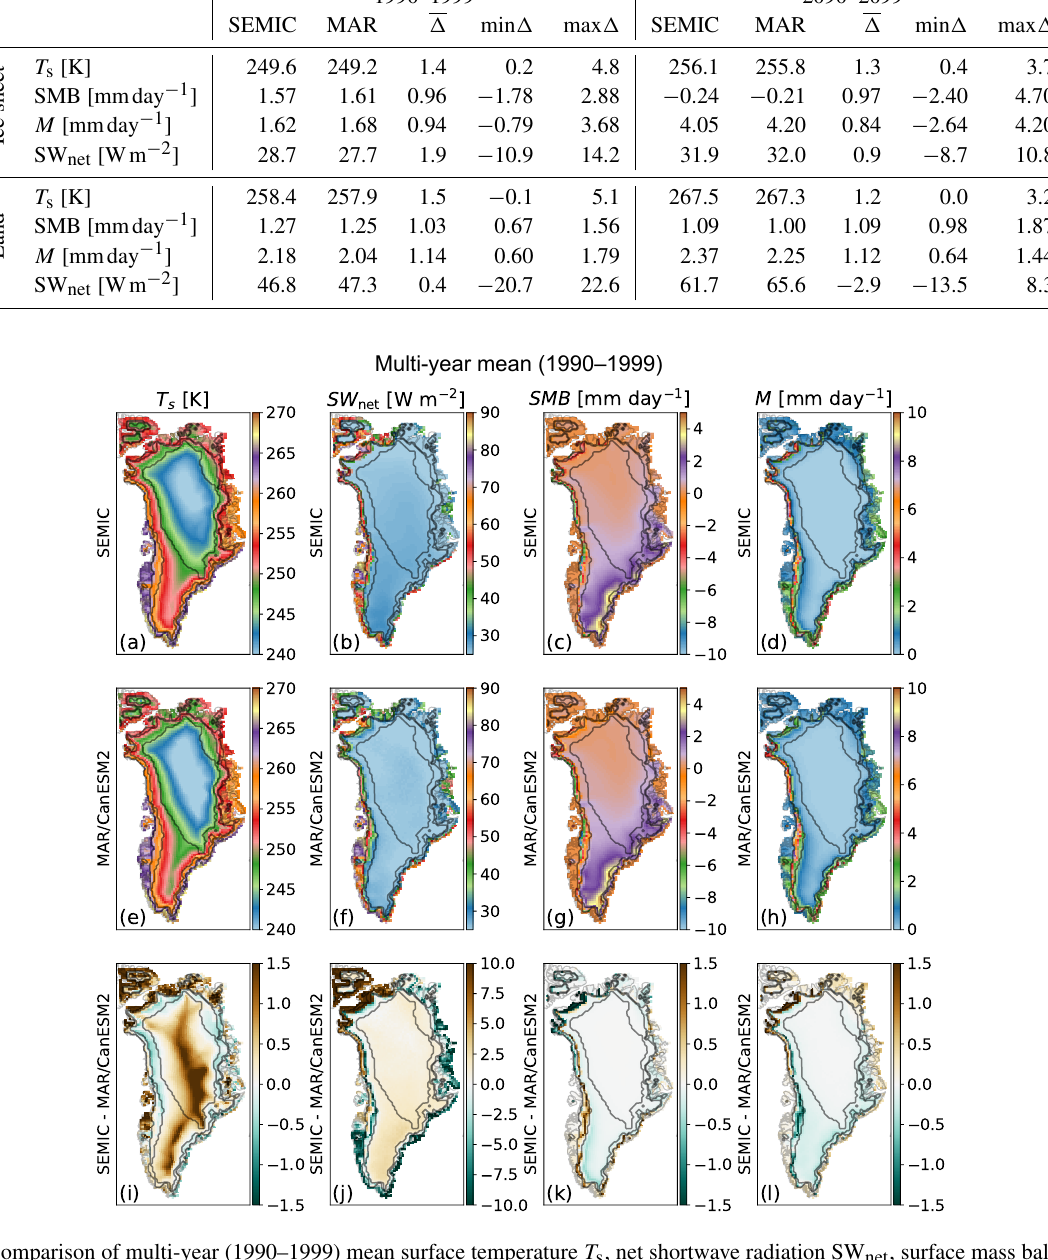
critical here; it allows melting and refreezing within one time step which would be prohibited